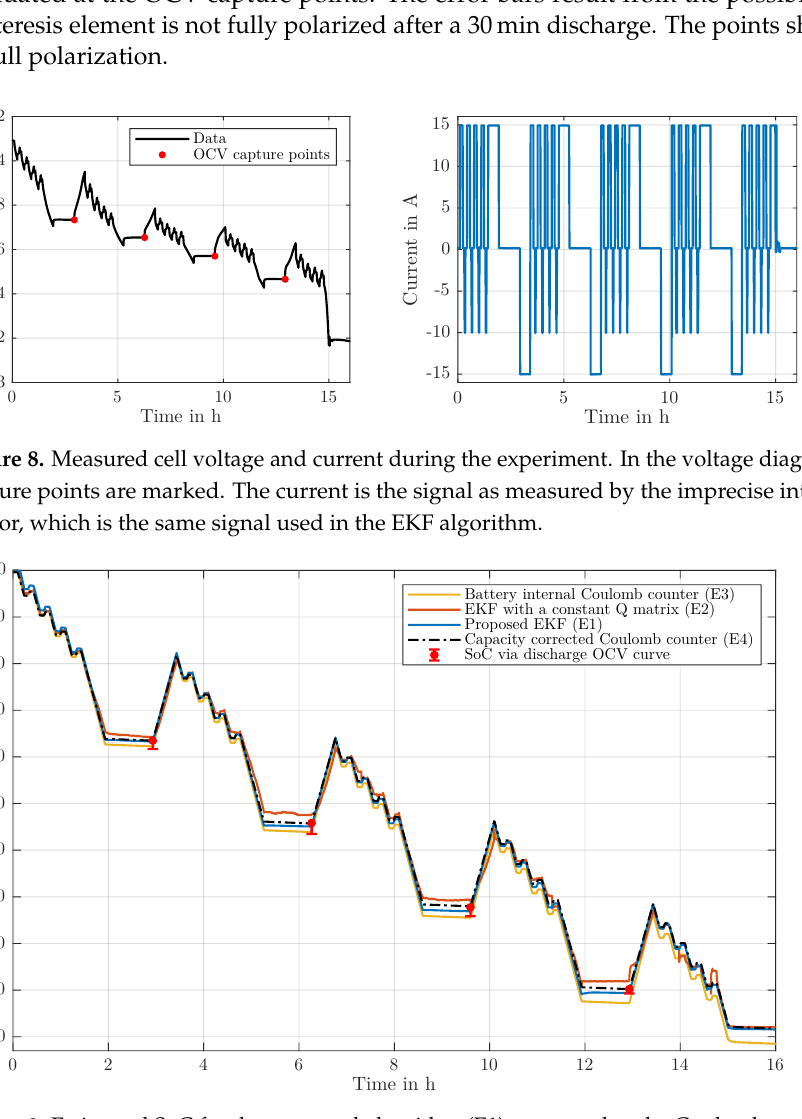
Figure 9. Estimated SoC for the proposed algorithm (E1) compared to the Coulomb counter based on the internal current sensor (E3), the empirically tuned EKF (E2) and the capacity corrected Coulomb counter based on a more precise current sensor